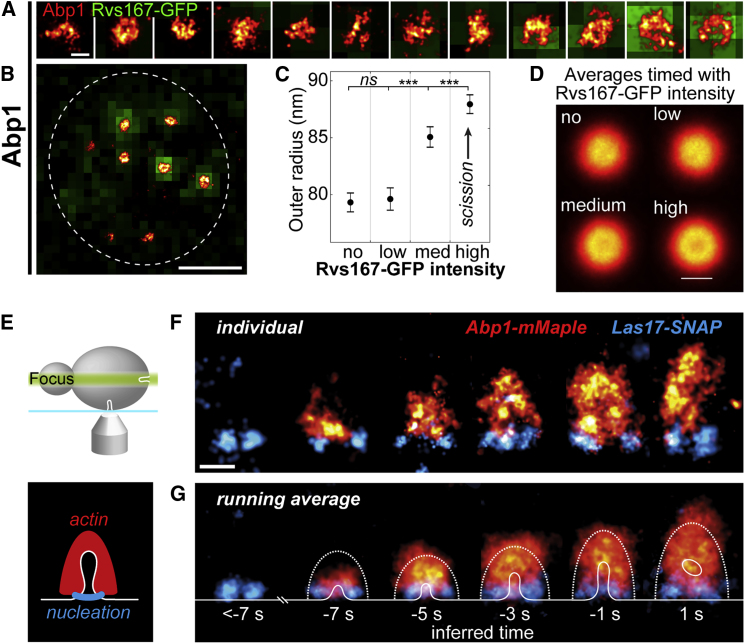
The Actin Network Emanates from the WASP Nucleation Zone(A and B) Abp1 in superresolution overlaid with diffraction-limited Rvs167-GFP as timing marker for vesicle scission at individual sites (A) and in a cell overview (B).(C) Outer radius of Abp1 for no, low, medium, and high Rvs167-GFP intensities (mean ± SEM; nno = 1,044; nlow = nmed = nhigh = 568; data in Table S2).(D) Average images of Abp1 for each time window. At medium and high Rvs167-GFP, a pronounced minimum in the center indicates the membrane invagination. See Figure S5 for radial profiles.(E) Schematic of the side-view perspective used in (F) and (G).(F) Dual-color side-view superresolution images of Las17-SNAP and Abp1-mMaple at individual sites. Images were rotated so endocytosis occurs upward, and sorted by the distance of Abp1 centroid to Las17 at the base.(G) Running-window averages of Las17 and Abp1 at endocytic sites. For comparison, average outer boundaries of the actin network (dotted lines), and average plasma membrane profiles (solid line) obtained by CLEM (Kukulski et al., 2012) are overlaid for each time point, as inferred from the images. ∗∗∗p < 0.001 from Wilcoxon rank-sum test.Scales bars represent 100 nm (A, D, and F) and 1 μm (B).See also Figure S5 and Table S2.